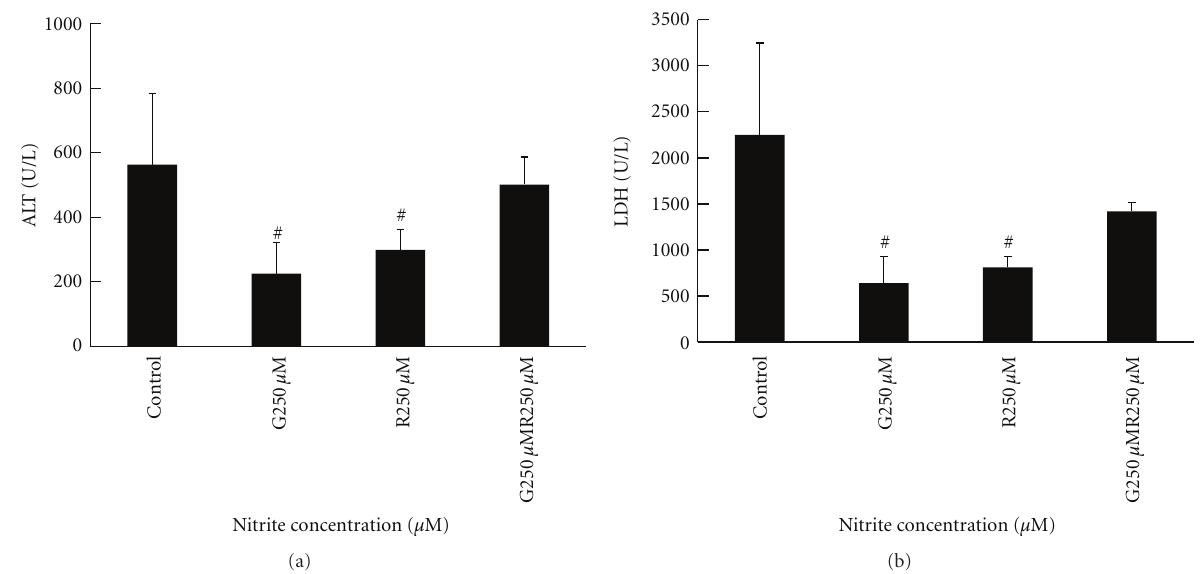
Figure 9: Nitrite administration to either the donor liver graft or recipient decreased hepatic enzyme release posttransplantation. Serum enzymes in only the nitrite-treated graft and recipient only groups decreased in syngeneic recipients 3 hours posttransplantation (ALT— 580 ± 118 versus 210 ± 90 versus 229 ± 41 versus 493 ± 92; LDH-2228 ± 1019 versus 652 ± 380 versus 810 ± 182 versus 1375 ± 202). Data are expressed as mean ± SE. # P < 0 . 05 for corresponding measurements.